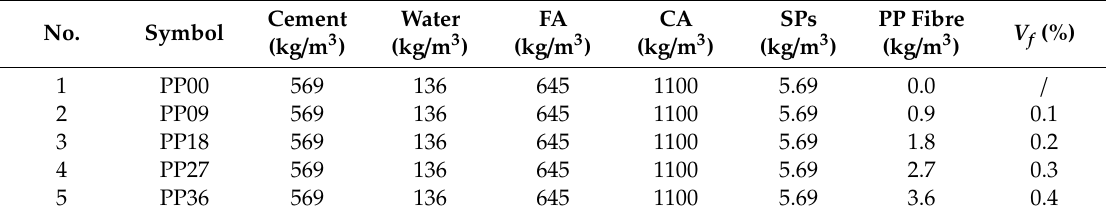
Table 5. Mixture proportions.